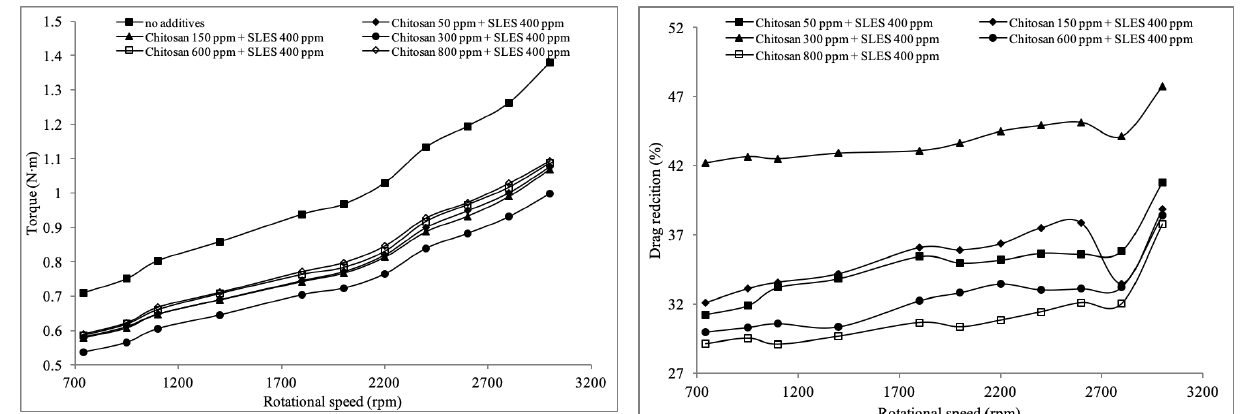
Figure 5: Torque values for chitosan–SLES complexes at different rotational speeds Figure 6: